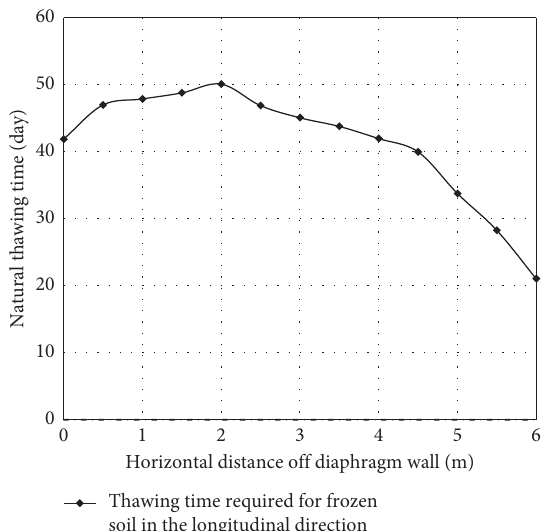
Figure 12: Thawing time required for frozen soil in the longitudinal direction along Path 2.